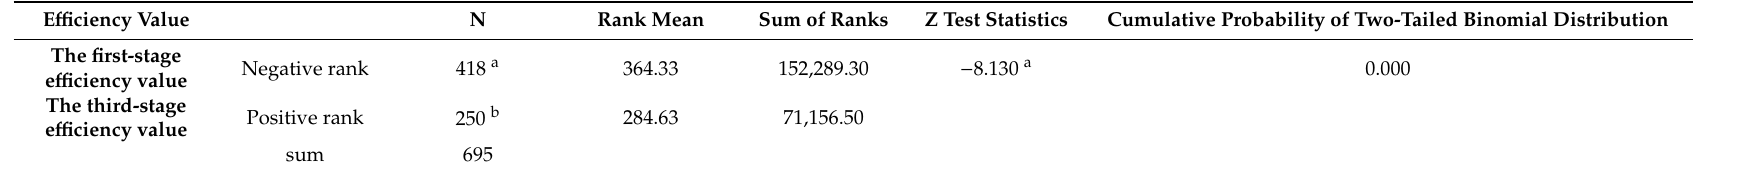
Table 4. The results of Wilcoxonrank-sum test.